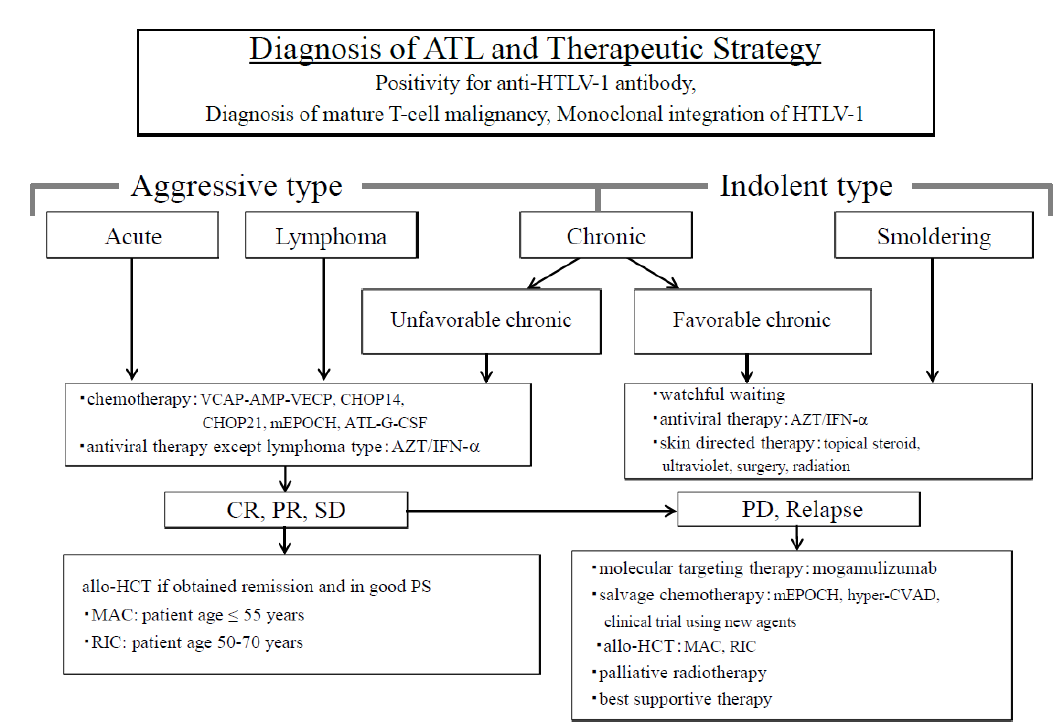
Figure 1. Diagnosis of adult T-cell leukemia/lymphoma (ATL) and the therapeutic strategy. ATL is divided into two types in order to decide treatment strategy; one is an aggressive type and the other is an indolent type. The aggressive types are acute, lymphoma, and unfavorable chronic, while the indolent types include the favorable chronic and smoldering types. Therapeutic strategies are decided based on these classifications. Allo-HCT, allogeneic hematopoietic cell transplantation; ATL-G-CSF, combination chemotherapy consisting of vincristine, vindesine, doxorubicin, mitoxantrone, cyclophosphamide, etoposide, ranimustine, and prednisone with granulocyte-colony stimulating factor support; AZT⁄IFN- α , zidovudine and interferon- α ; CHOP, cyclophosphamide, doxorubicin, vincristine, and prednisone (CHOP14 is performed every 2 weeks, and CHOP21 is performed every 3 weeks); CR, complete remission; hyper-CVAD, cyclophosphamide, vincristine, doxorubicin, and dexamethasone; MAC, myeloablative conditioning; mEPOCH, etoposide, prednisone, vincristine, cyclophosphamide, and doxorubicin (EPOCH) with modifications; PD, progressive disease; PR, partial remission; PS, performance status; RIC, reduced-intensity conditioning; SD, stable disease; VCAP − AMP − VECP, vincristine, cyclophosphamide, doxorubicin and prednisone (VCAP)-doxorubicin, ranimustine and prednisone (AMP) − vindesine, etoposide, carboplatin, and prednisone (VECP). Figure 1 was reproduced and modified from Figure 1 in Utsunomiya et al. ( Cancer Science , 2015) [19]. Reprint is permitted by Cancer Science